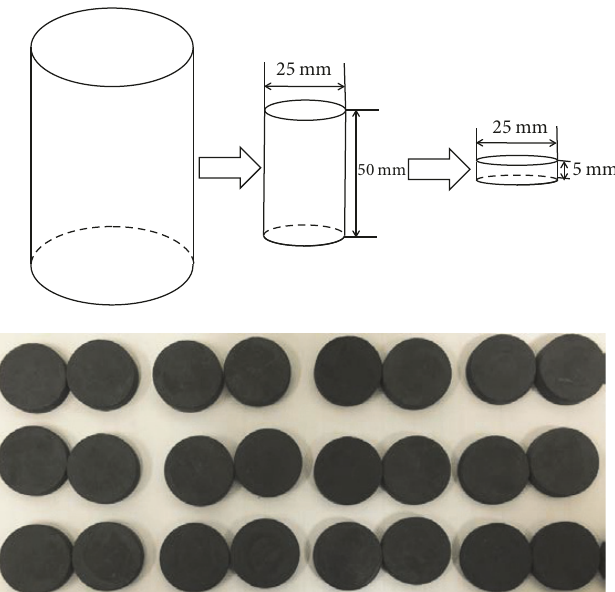
Figure 3: Schematic diagram of cores and disks used for Brazilian splitting testing.